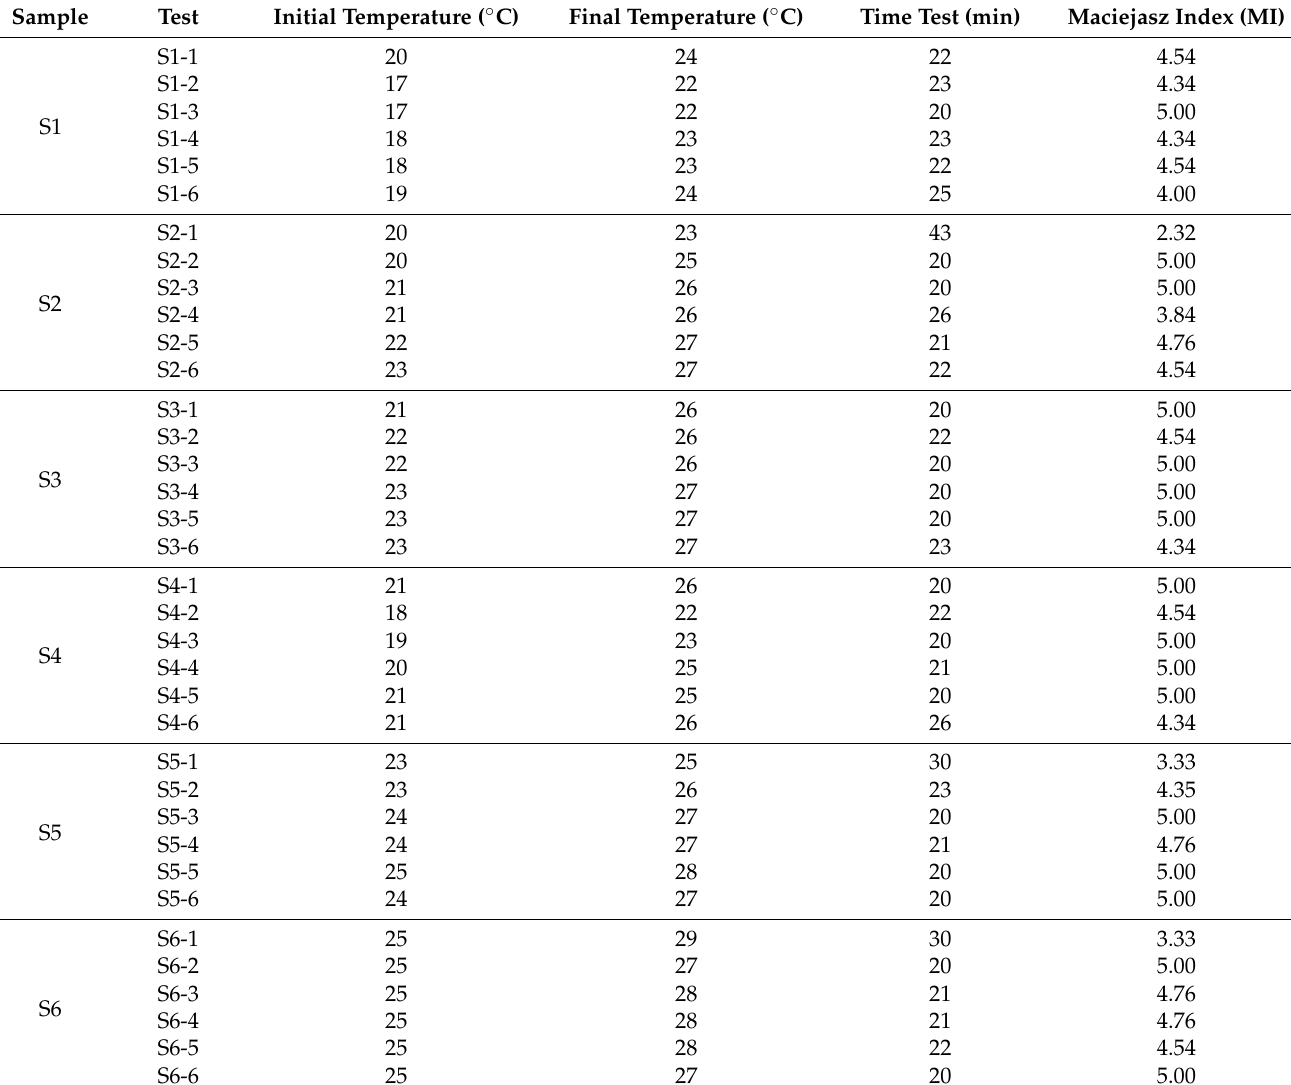
Table 4. Results sample S1 (C 3 H 8 O).